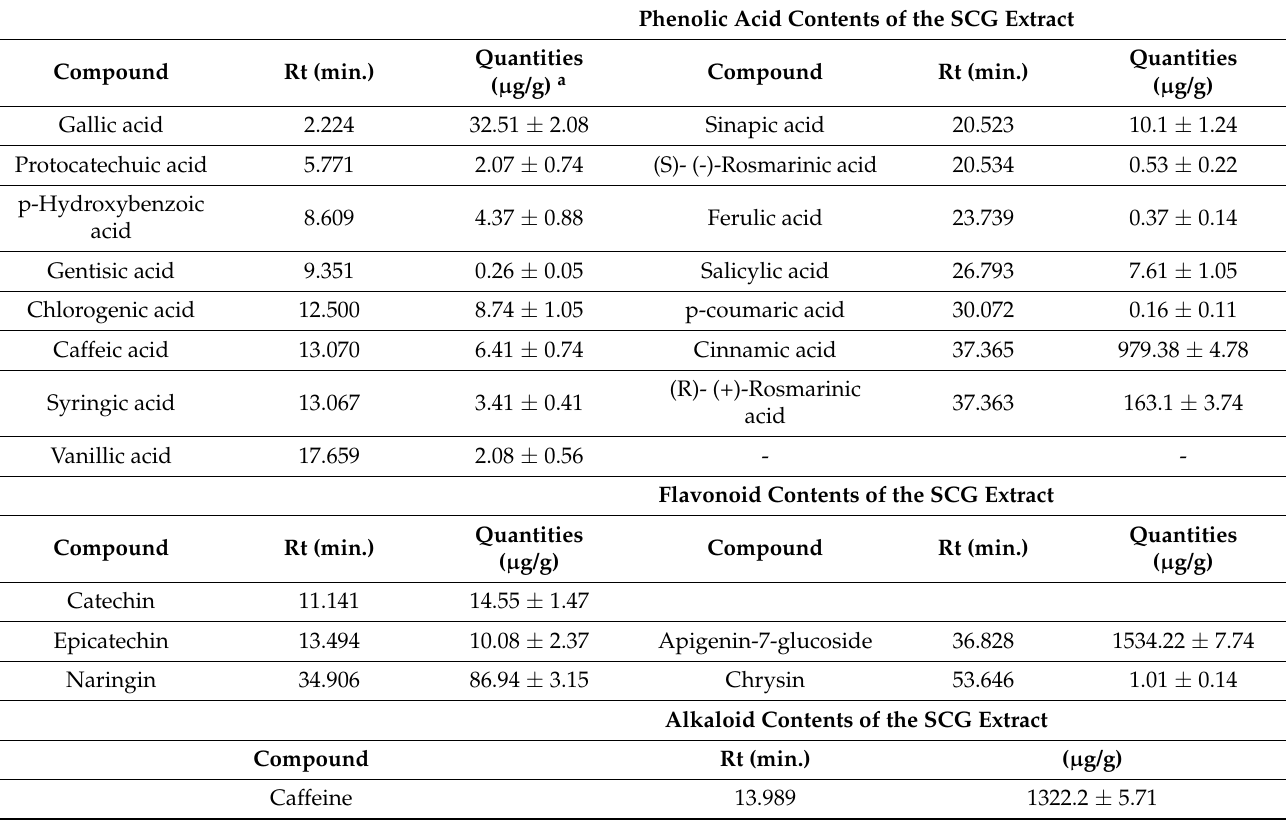
Table 1. Contents of phenolic acids, flavonoids, and caffeine determined in the methanol SCG